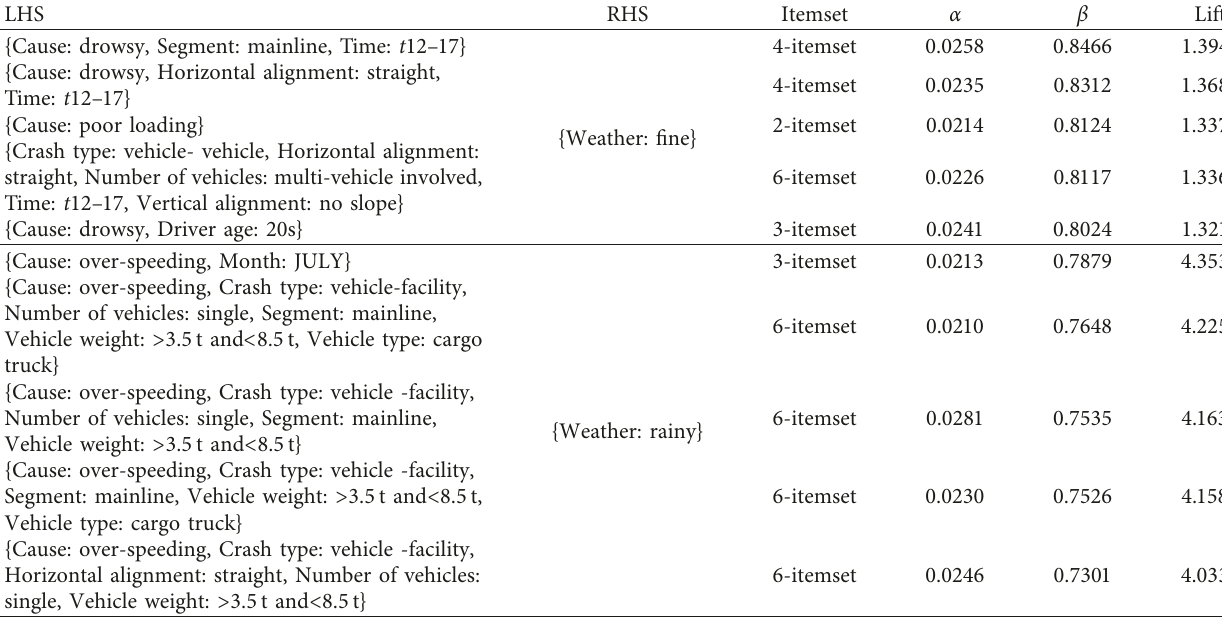
Table 5: Association rules by weather condition.